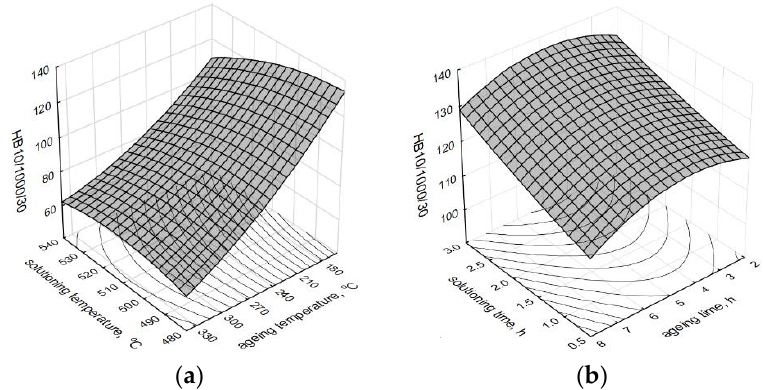
Figure 6. Influence of the heat treatment parameters on the hardness of the alloy. ( a ) t s and t a , ( b ) τ s and τ a.